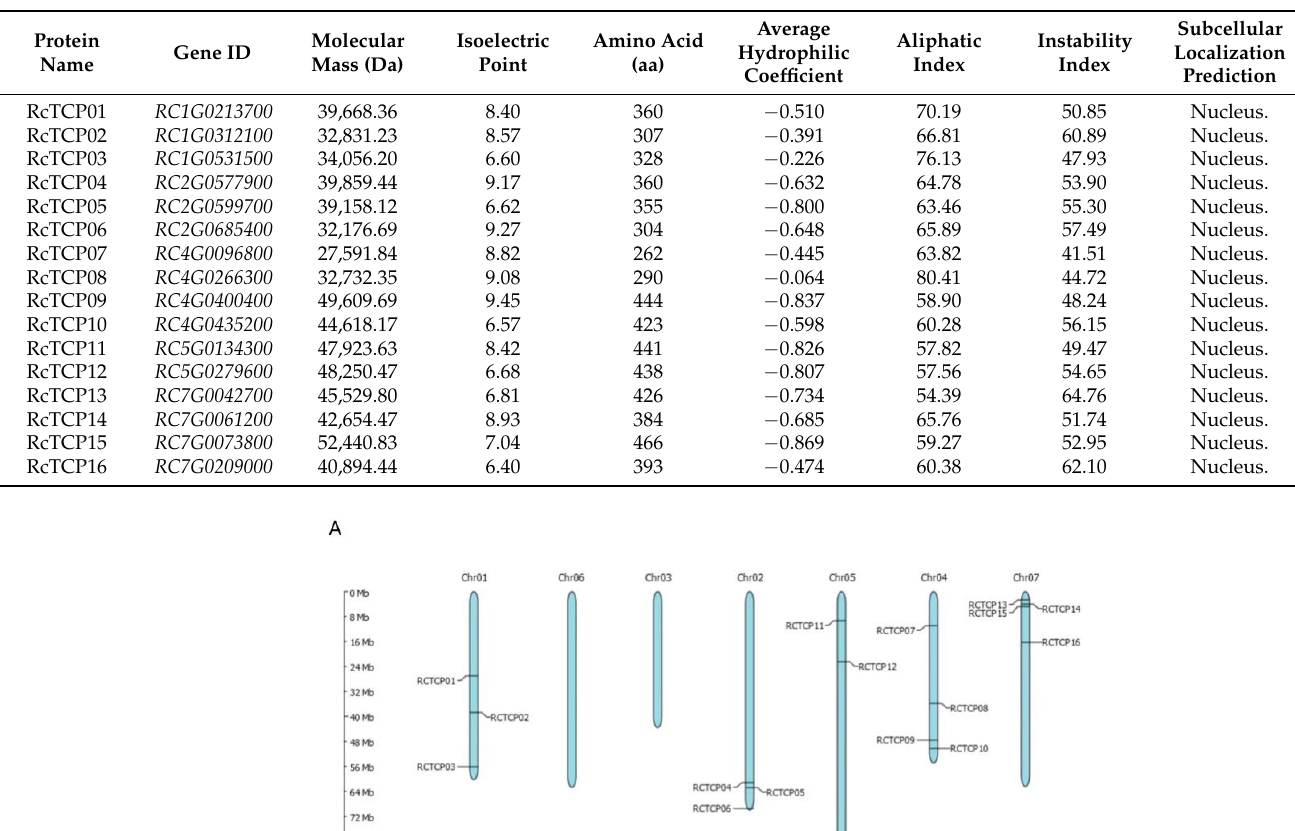
Table 1. Physicochemical properties and subcellular localization of RcTCP proteins.